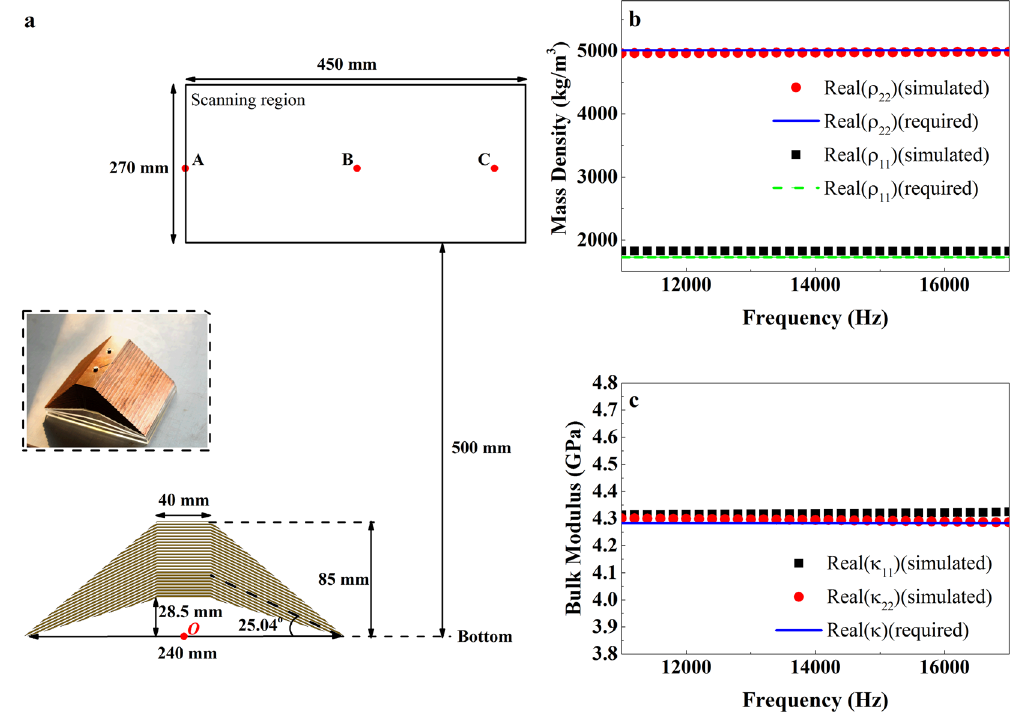
Figure 3. Experimental setup and prototype of the carpet cloak. ( a ) Schematics of the experimental setup and the sample. The scanned area is shown as the black frame. A, B and C are three particular points to extract the time domain signals. Inset: the photograph of the quasi-two-dimensional carpet cloak which consists of layered brass plates. Retrieved effective ( b ) mass density and ( c ) bulk modulus of the designed unit cell from 11kHz to 17 kHz in two principal axes. The horizontal lines in ( b and c ) show the parameters required by the